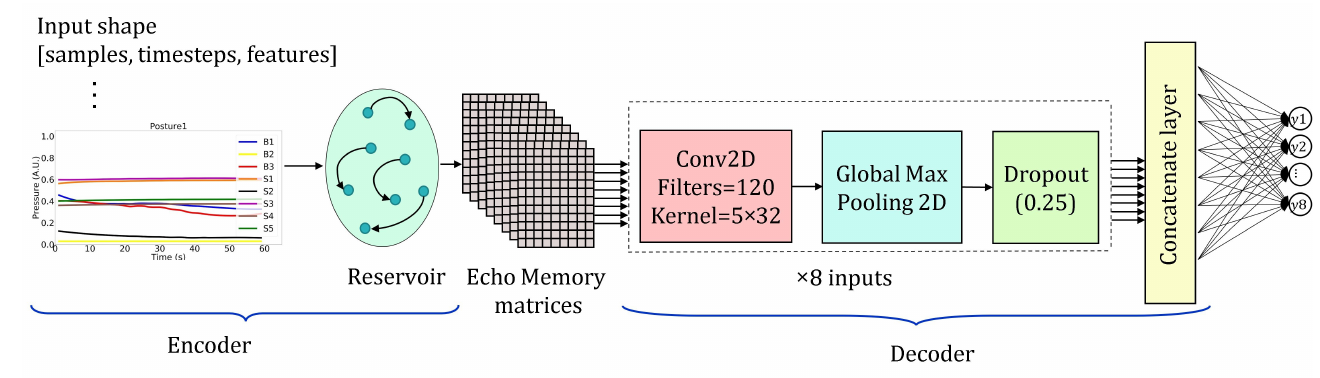
Figure 9. The adopted EMN model architecture. Input has 3D shape, hidden layers consists of an encoder and a decoder. The encoder converts the 3D inputs to echo memory matrices; the decoder consists of the fusion of the features extracted from the 8 sensors signals matrices by CNN2D layer, together with the max pooling and dropout layers. The output layer has 8 neurons for 8 postures